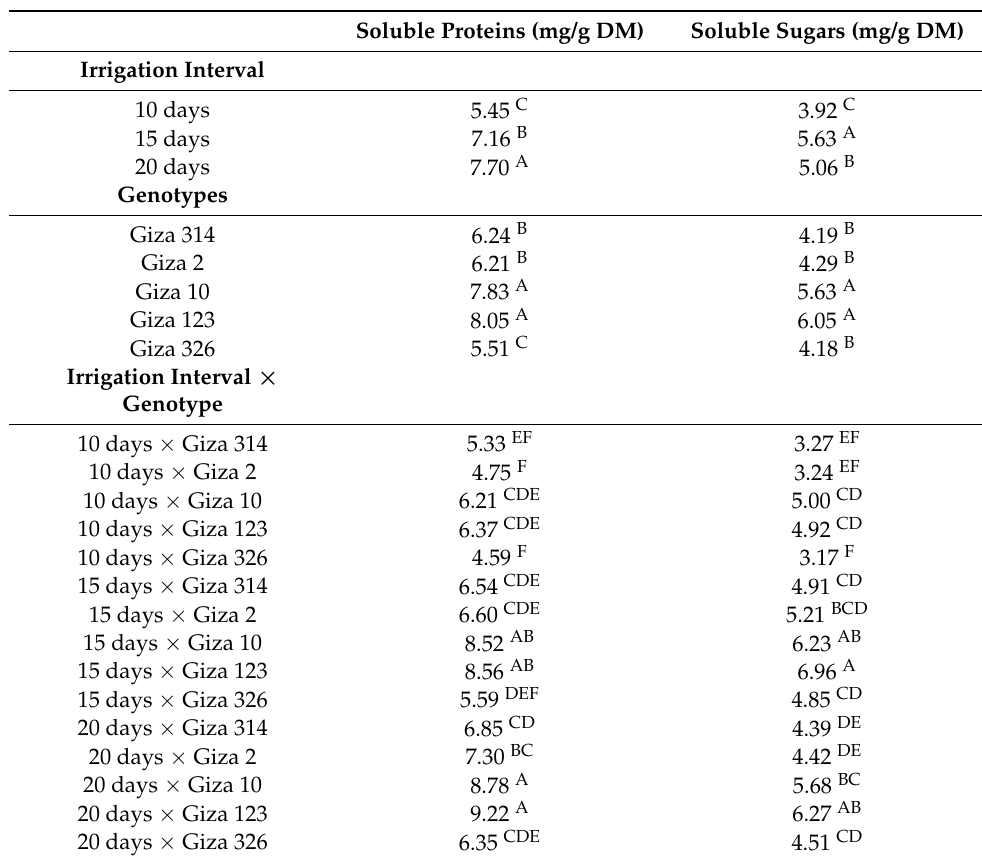
Table 8. Soluble proteins and sugars of five maize genotypes as affected by normal (10 days), mild (15 days), and severe (20 days) water stress at the vegetative stage. Means within the same column distinguished by different letters differ significantly according to the Tukey’s posthoc HSD test at p =